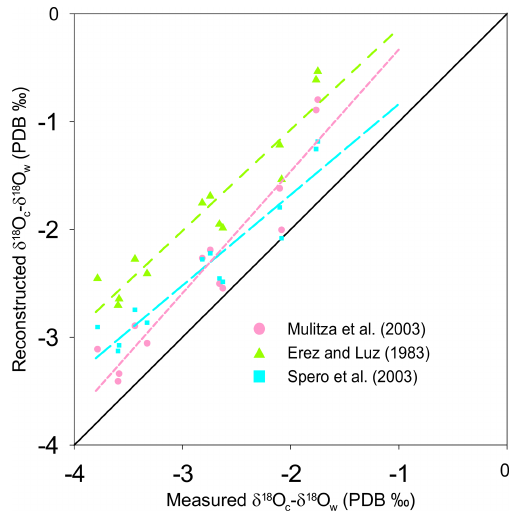
Figure 4. Reconstruction of δ 18 O c - δ 18 O w by inserting the mea- sured temperature into three δ 18 O-based paleotemperature equa- tions: the equation of Spero et al. (2003) (light blue squares, large light dashed blue line), the equation of Mulitza et al. (2003) (pink dots, small dashed pink line), and the equation sorted by Erez and Luz (1983) (green triangles, dashed green line) plotted versus mea- sured δ 18 O c - δ 18 O w (‰ PDB). The diagonal line represents the 1 : 1 regression.